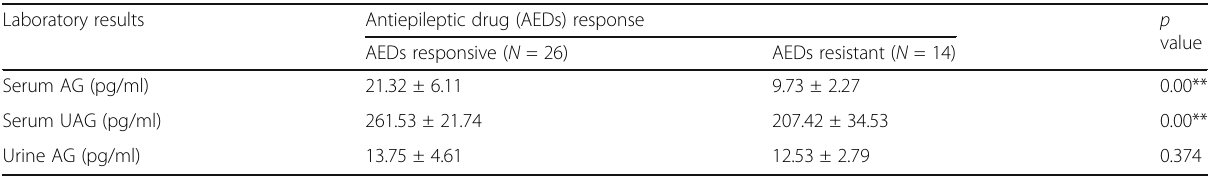
Table 4 Relation between laboratory results and antiepileptic drugs response Laboratory results